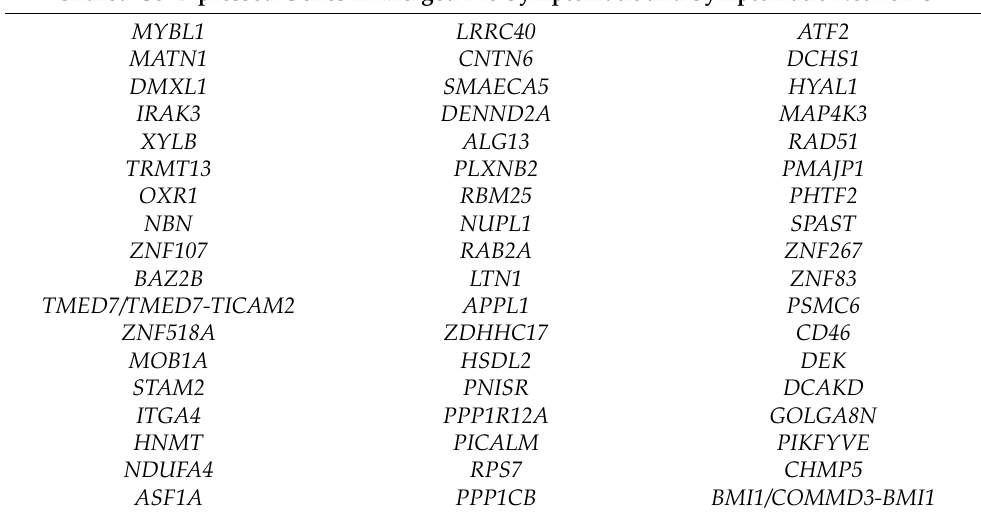
Table 2. Shared co-expressed genes in merged networks for controls versus pre-symptomatic and controls versus symptomatic HD datasets